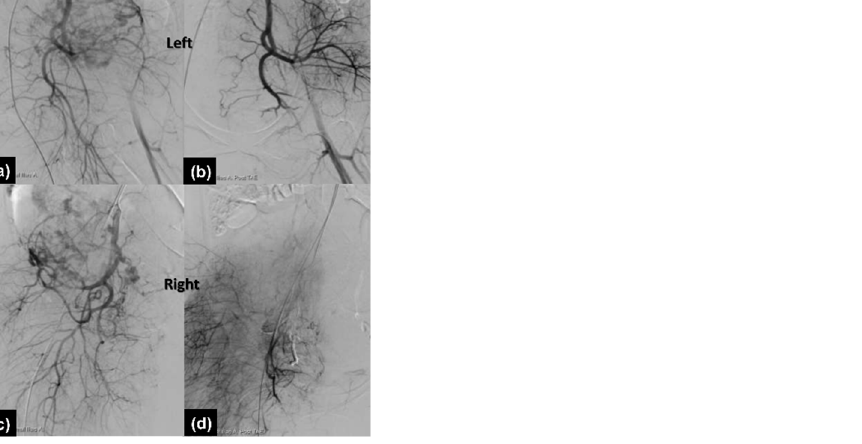
Figure 3. Uterine angiogram before and after the procedure (left to right). ( a and b ) Left. ( c and d ) Right.